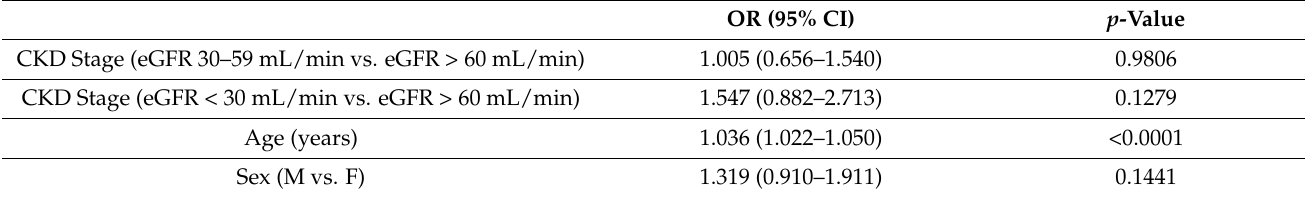
Table 4. Logistic model on the CKD effect on incident AF adjusted by age and sex. Patients with permanent AF were excluded from the model ( n = 96). n = 2720, AF = 143.